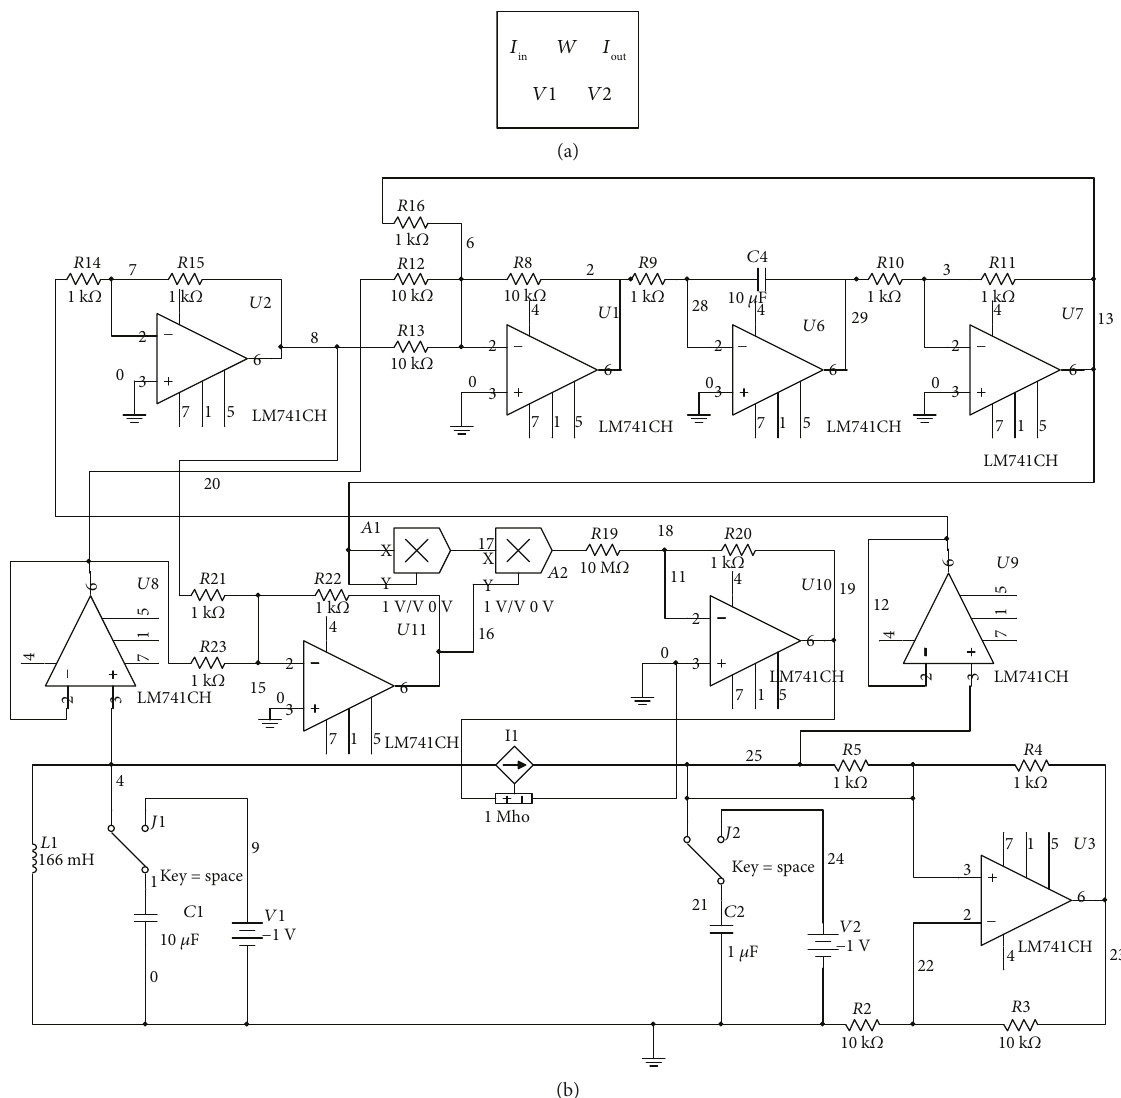
Figure 11: The memristor and its internal circuit. (a) The memristor. (b) Its internal circuit.